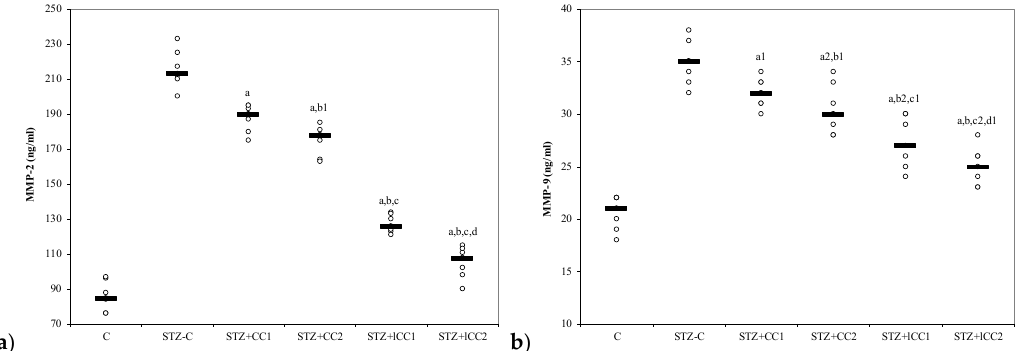
Figure 4. Variability of matrix metalloproteinases (MMP) by groups: ( a ) MMP ‐ 2, ( b ) MMP ‐ C = control; STZ ‐ C = streptozotocin control; STZ + CC1 = STZ and 1 mg/100 g bw CC as pre ‐ treatment; STZ + CC2 = STZ and 2 mg/100 g bw CC as pre ‐ treatment; STZ + lCC1 = STZ and pre ‐ treatment with 1 mg/100 g bw lCC; STZ + lCC2 = STZ and pre-treatment with 2 mg/100 g bw lCC. a p -values < 0.002 as compared to STZ-C group excepting a1 0.0181 and a2 0.0088; b p -values as compared to STZ + CC1 group of 0.0017 excepting b1 0.1797 and b2 0.0027; c p -values as compared to STZ + CC2 group < 0.002 excepting c1 0.0553 and c2 0.0027; d p -value as compared to STZ + lCC1 group of 0.0017 excepting d1 0.0845.